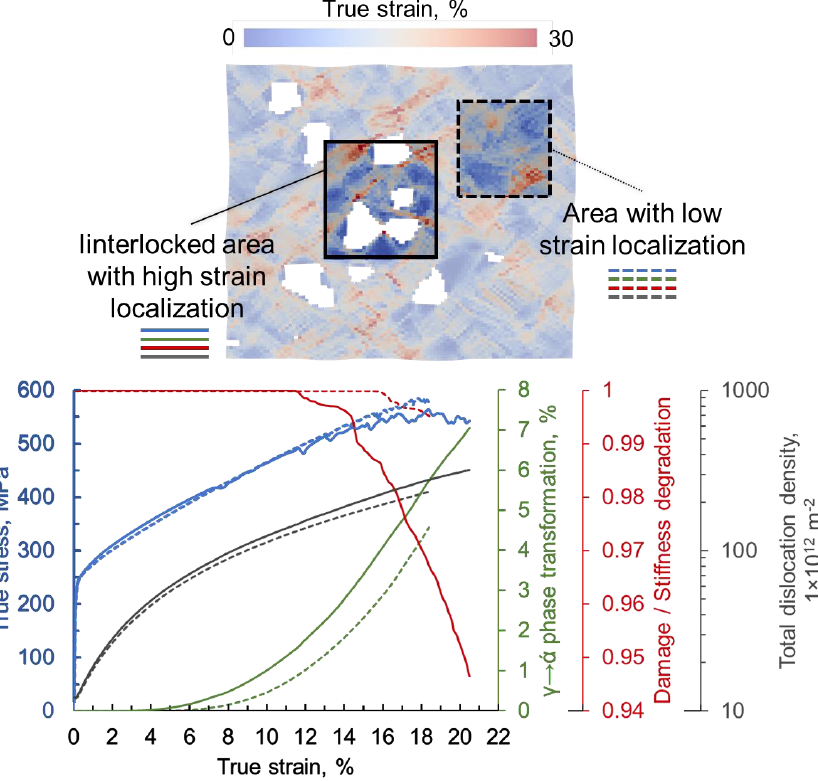
Figure 7. Comparison of averaged true stress, phase transformation, stiffness degradation, and dislocation density distribution relative to true global strain in an interlocked (solid line) and free (dotted line) austenitic zone. Refer to the top schematic with marked areas of interest.